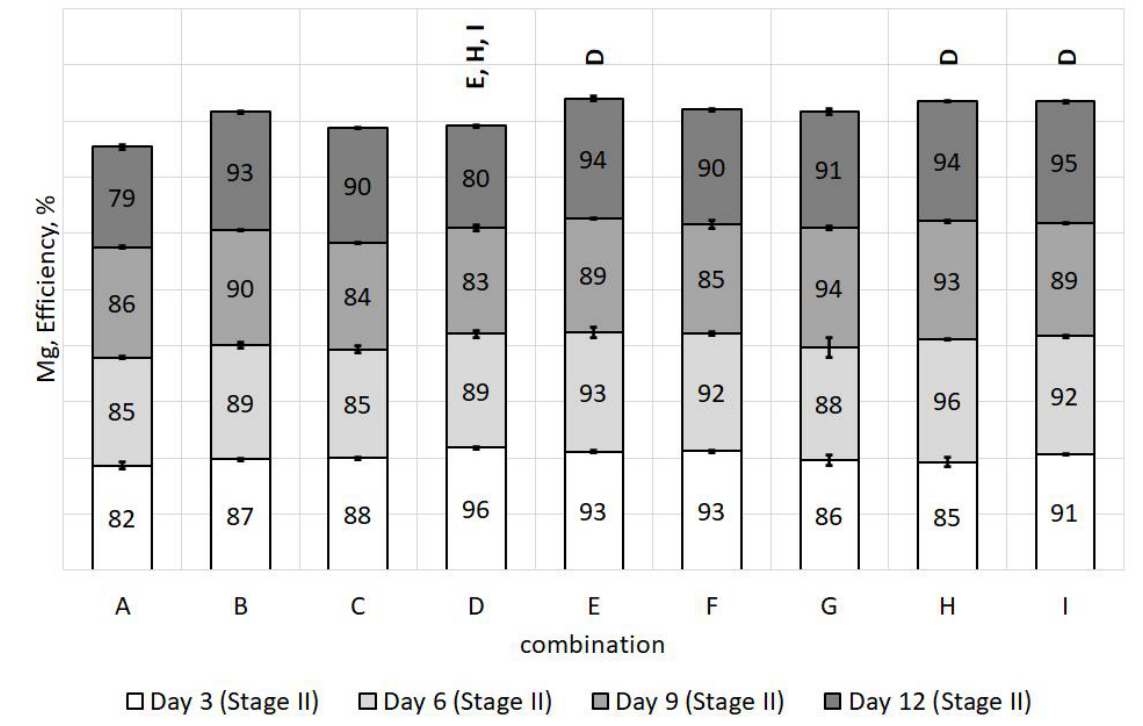
Figure 16. Effectiveness of Mg release to the dissolved fraction of leachate (Stage II).